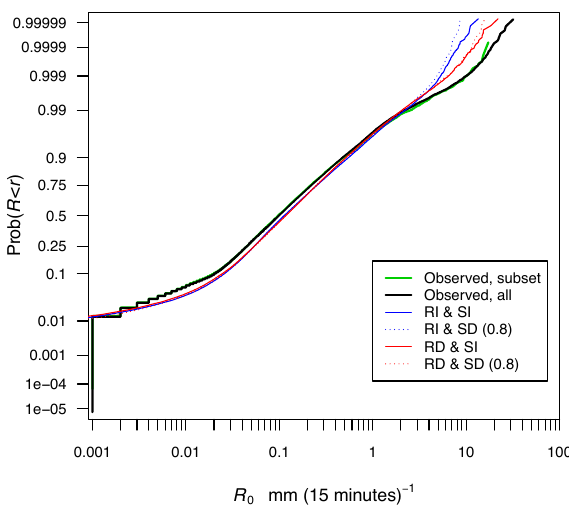
Fig. 9. Cumulative distribution function (CDF) of non-zero rain- fall rates from all observations, of the subset of 2000 15-min in- tervals used to initialize the large-scale rainfall R 0 for the simu- lations, and of the simulations. Simulated rainfall was generated using log-stable Models SI σ /RI σ /LS, SD σ /RI σ /LS with γ =0.8, SI σ /RD σ /LS, and SD σ /RD σ /LS with γ =0.8.